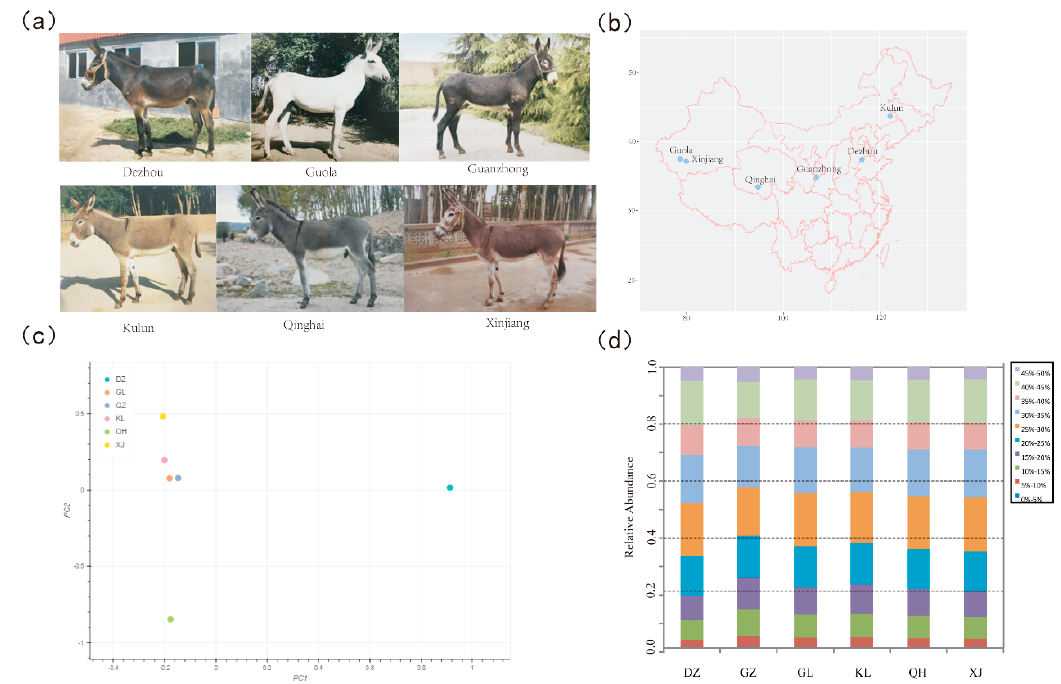
Figure 1. Summary of six donkey breeds. ( a ) The six donkey breeds included in this study. ( b ) Geographic map indicating the distribution of the donkeys sampled in this study. Each point represents the location of sampling. The map was generated using the ‘ggmap’ package in R (version 3.5.2) (R Core Team 2018). ( c ) Principal components analysis (PCA) of six donkey breeds using the PC1 and PC2 components. DZ: Dezhou; GL: Guola; GZ: Guanzhong; KL: Kulun; QH: Qinghai; and XJ: Xinjiang. ( d ) A schematic representation of minor allelic frequency (MAF) plotted as a function of distance for each donkey population.